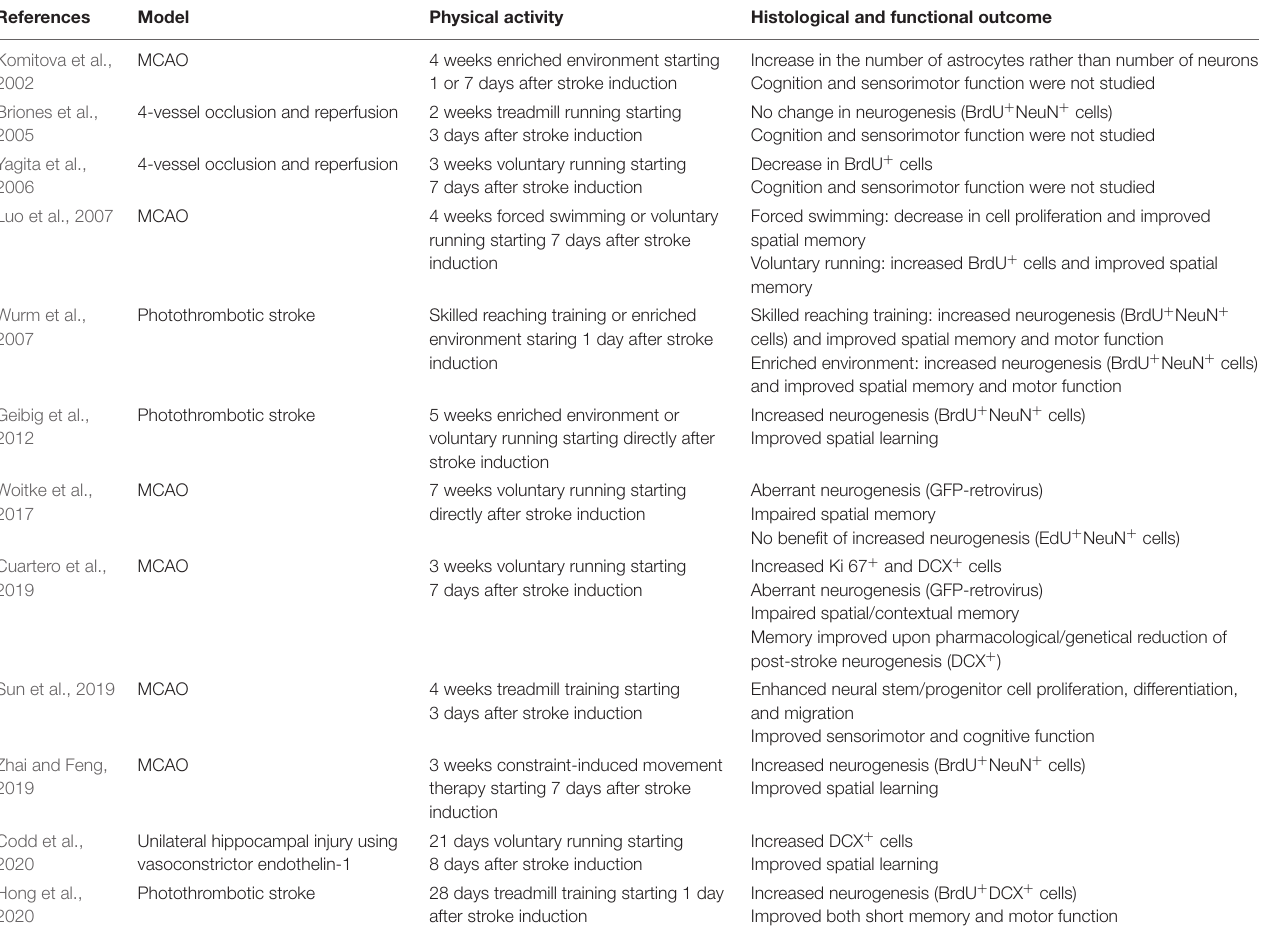
TABLE 1 | Effect of physical activity on neurogenesis and cognitive function after